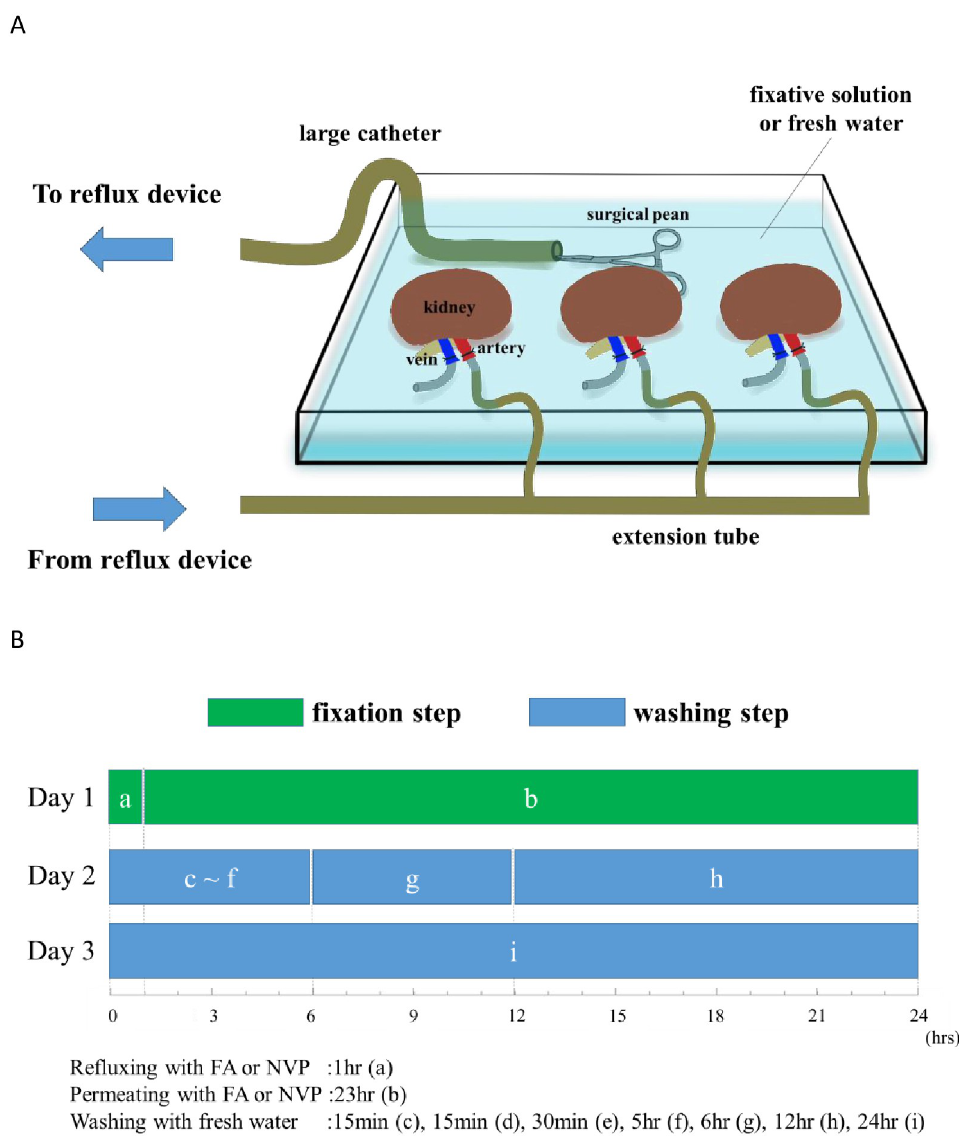
Fig 1. Circulating system and schedule for preparing the surgical training kidney. (A) Circulating system: The extension tube was cannulated into the lumen of the renal artery and vein of the pig kidney; the kidney was submerged the fixative solution bath. The reflux system was constructed to recirculate in its bath. The fixative solution was continuously collected from the tip of a large catheter, which was secured with a surgical pean (hemostat) that typically controls bleeding. A large catheter was connected to the extension tube, and the fixative solution was continuously refluxed into the renal artery. The fixative solution that had cycled through the kidneys was drained continuously from the renal vein to its bath. The drained fixative solution was collected from the large catheter again. (B) Schedule: The green bar is the fixation step. The blue bar is the washing step. a) is refluxed time. b) is permeated time. From c) to i) are replaced time. Fixation was first refluxed with FA or NVP fixative for 1 hour in its bath, then, by permeation for 23 hours. Following continuous freshwater reflux in the washing step, it was replaced periodically at 15 minutes, 30 minutes, 60 minutes, 6 hours, 12 hours, and finally 24